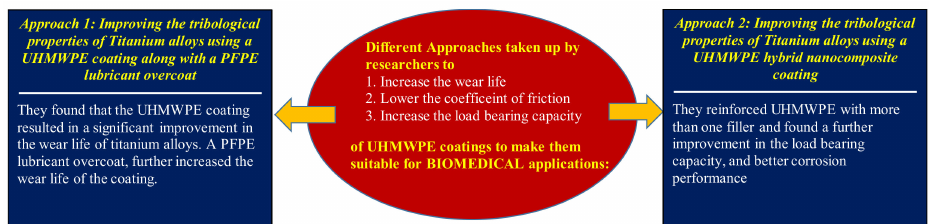
Figure 20. Schematic of the different approaches used by researchers to make the UHMWPE coatings suitable for biomedical